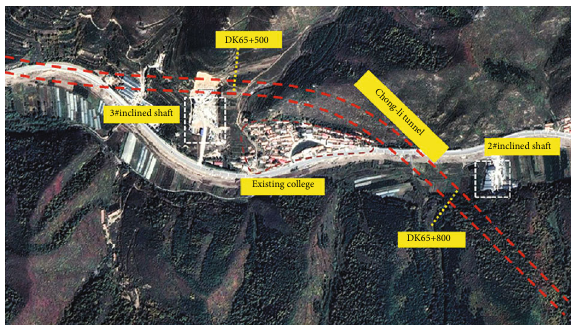
Figure 2: Plan location map of the underpass railway